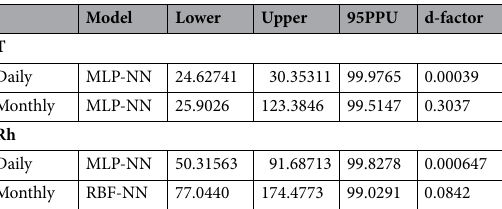
Table 4. Results of 95PPU and d-factor for best models in prediction daily and